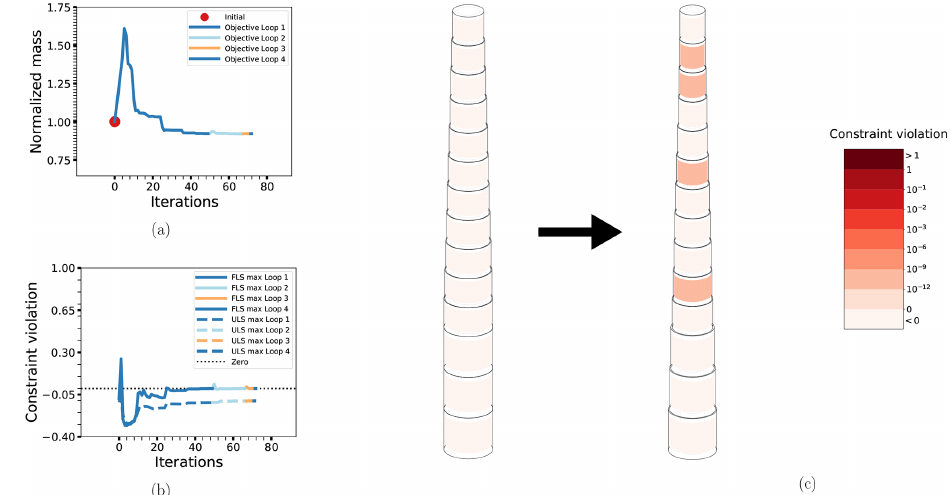
Figure 12. The optimization process for case OC3-PA-DT: the objective function (a) , maximum non-linear constraint violations (b) and the change in the design from initial to final configuration (c) . Details as in previous figures.